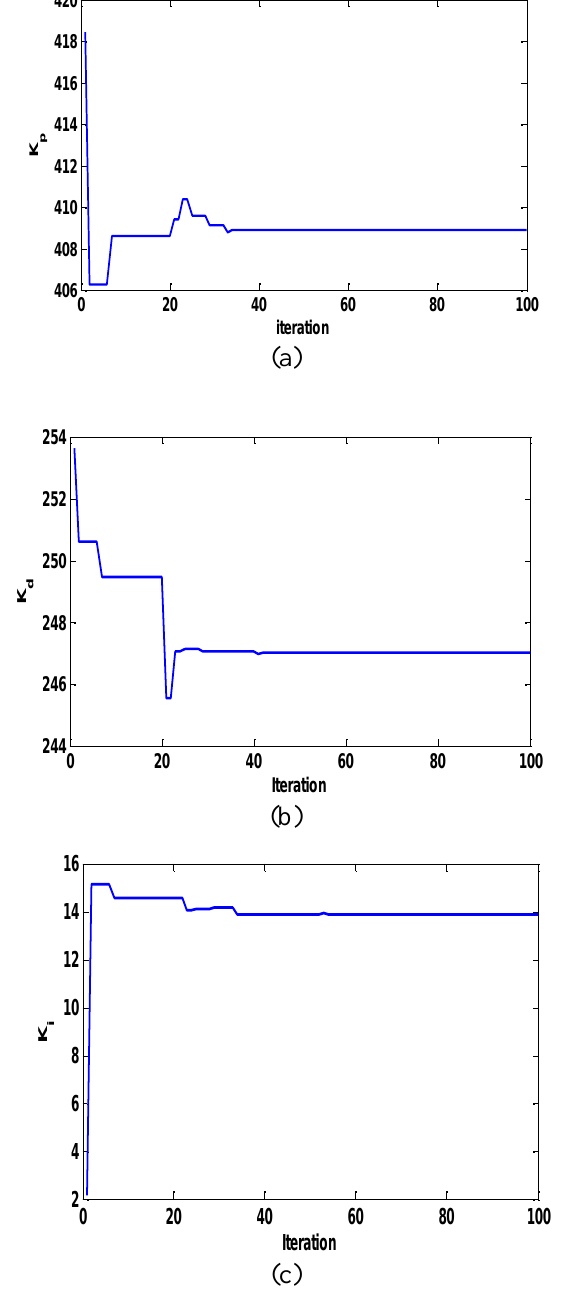
Figure 8. Finding PID gains: (a) trajectory of , (b) trajectory of , (c) trajectory of .